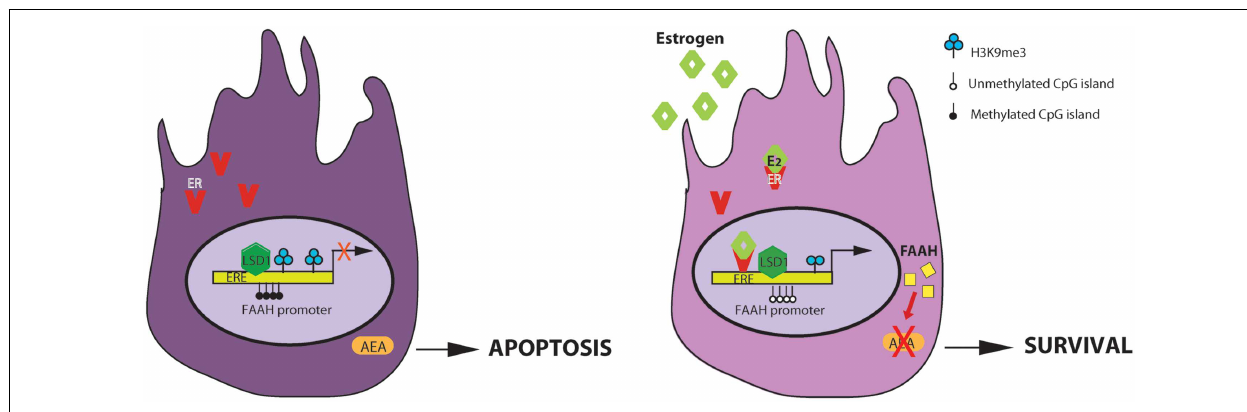
FIGURE 2 | Regulation ofAEA-degrading enzyme FAAH expression by estrogen in Sertoli cells . E 2 regulates FAAH transcription by direct binding of estrogen receptor (ER) and epigenetic mechanisms including histone modification and DNA methylation. On the left: in the absence of estrogens, faah proximal promoter is methylated at DNA CpG sites and at lysine 9 of H3 histone and it is not competent for transcription.The final outcome is an increase AEA-induced apoptosis of Sertoli cells. On